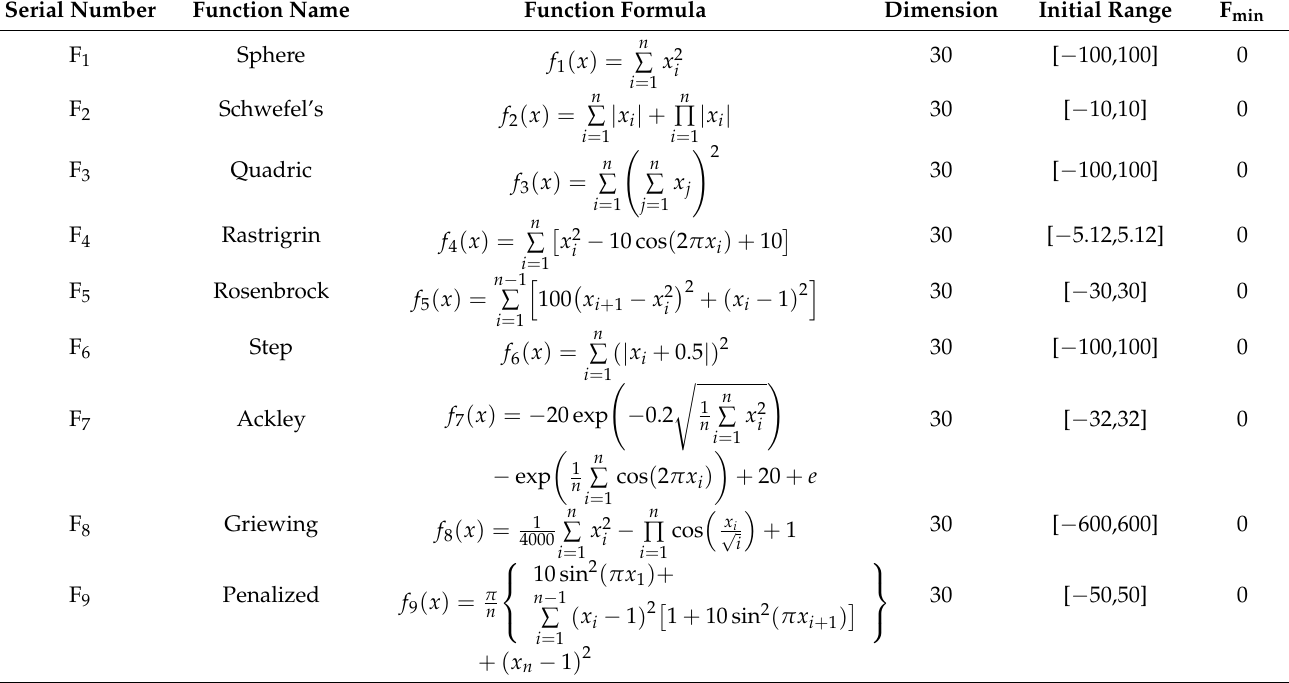
Table 1. Benchmark